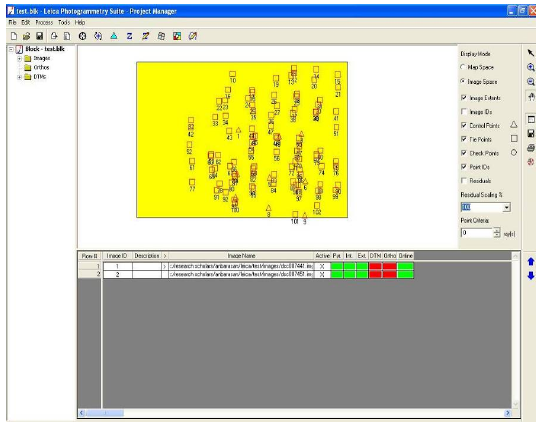
Figure 4: Automatic Tie Points